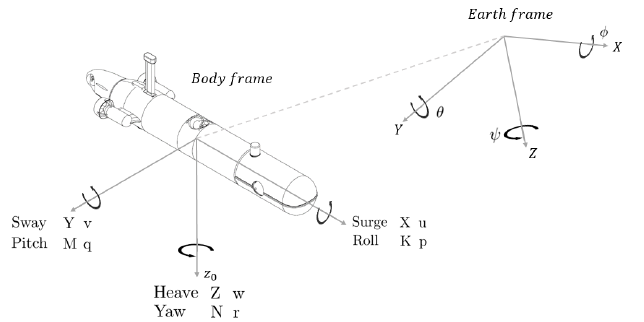
Figure 5. Body-fixed and Earth-fixed reference